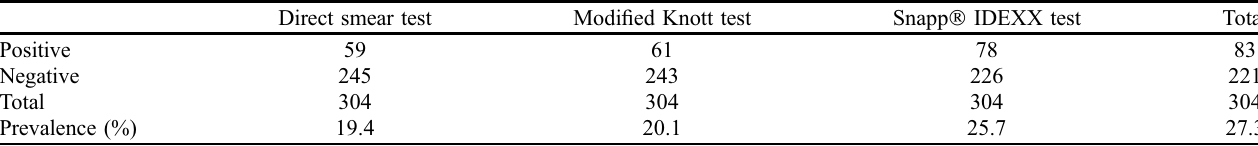
Table 1. Comparison of results of different diagnostic techniques for